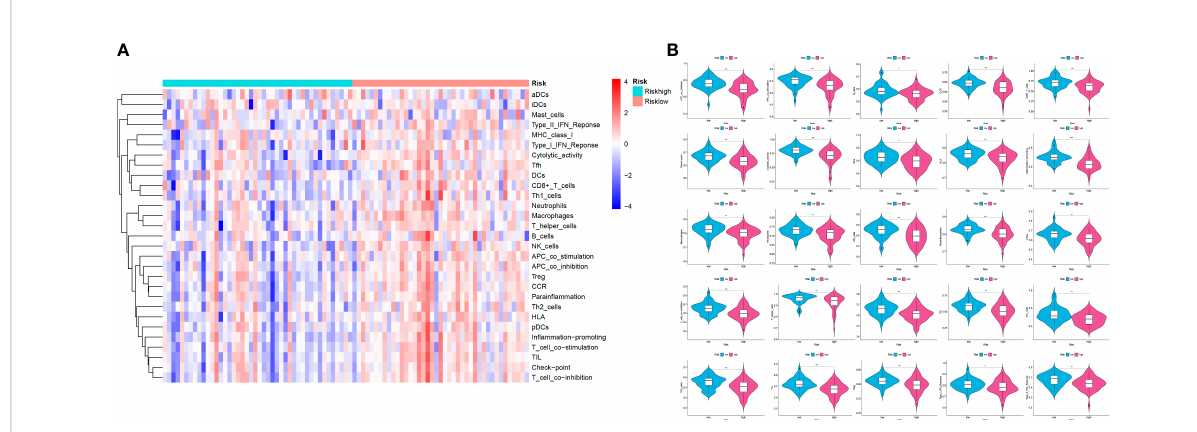
FIGURE 12 Analysis of ssGSEA in the two risk groups to explore the immune in fi ltration. (A) A heatmap of 29 immune cells and functions utilizing ssGSEA analysis in the two groups. (B) Violin plots of 25 signi fi cant differential immune functions between the two groups. We could know that all the 25 immune functions are downregulated, which means a immunosuppressive environment in OS patients. “ * ” represented “ p<0.05 ” , “ ** ” represented “ p<0.01 ” ,and “ *** ” represented “ p<0.001 ” .